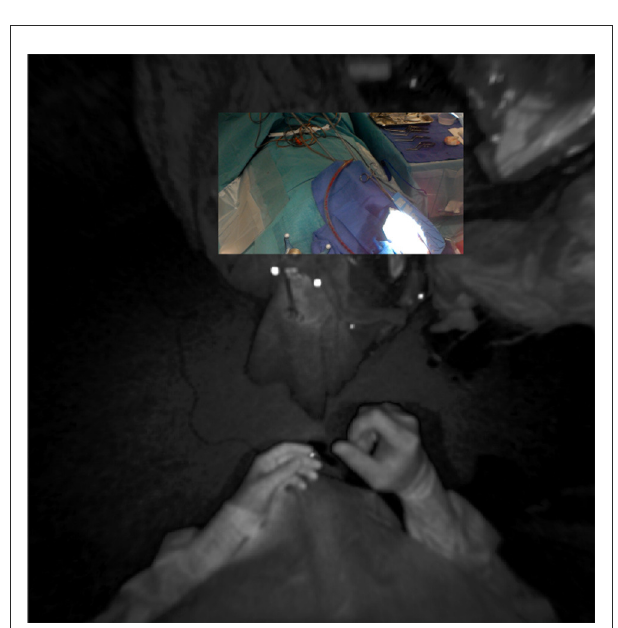
FIGURE13 Registration of RGB and infrared sensor maps on the HoloLens device, demonstrating the more favorable tracking frustum afforded by the infrared sensor’s downturned orientation and wider field-of-view (180 ◦